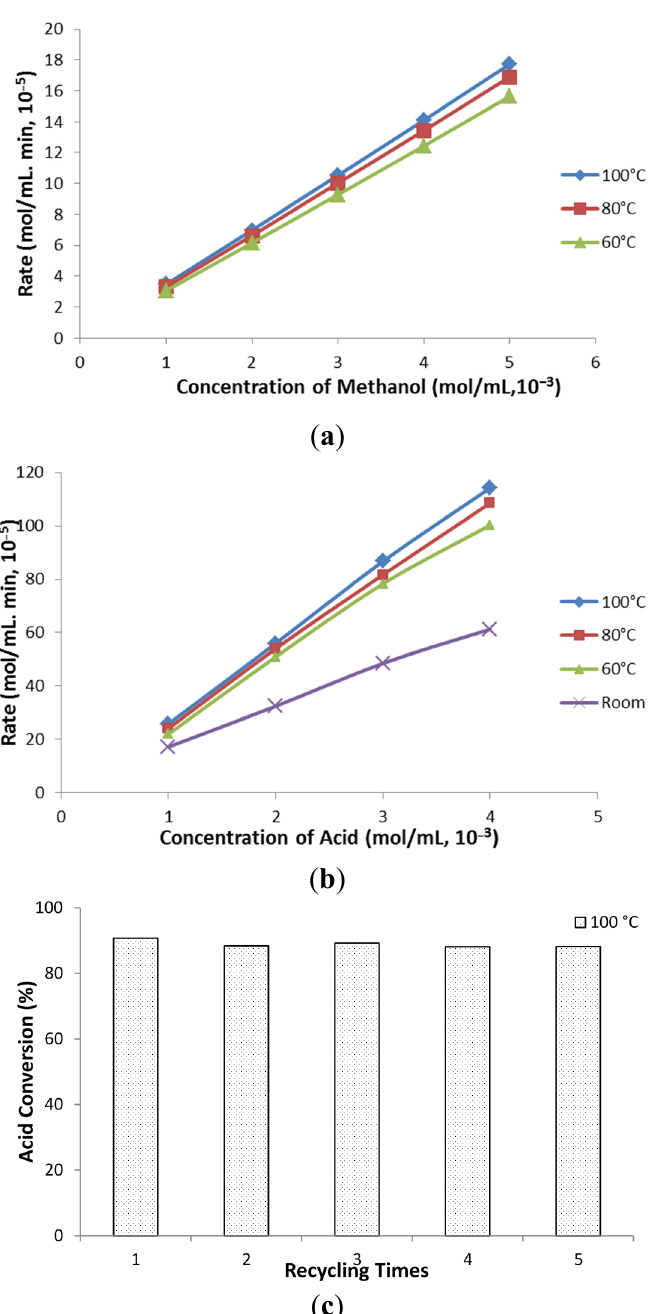
Figure 3. Effect of acid and methanol on initial esterification reaction rate at reaction time of 2 h, catalyst loading of 2 wt % (mass/mass), at temperature from 60 to 100 °C: ( a ). Concentration of methanol; ( b ). Concentration of acid; ( c ). Catalyst reusability in acid to methanol ratio of